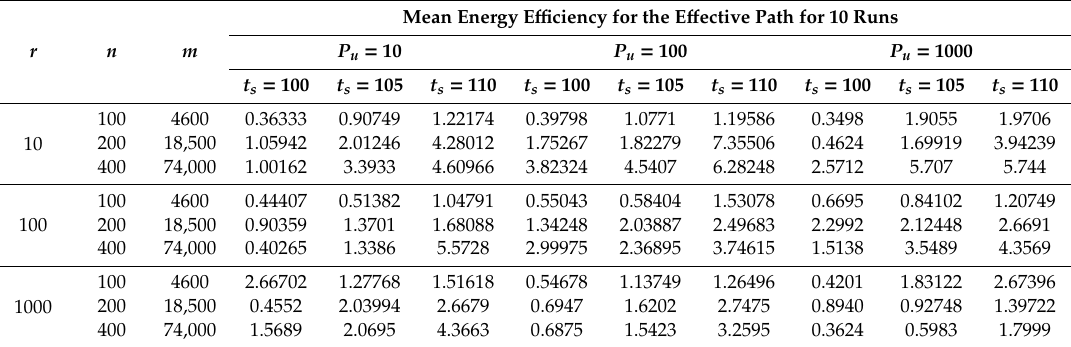
Table 4. Mean energy e ffi ciency for the e ff ective path for the SESE algorithm for 1 Mb .